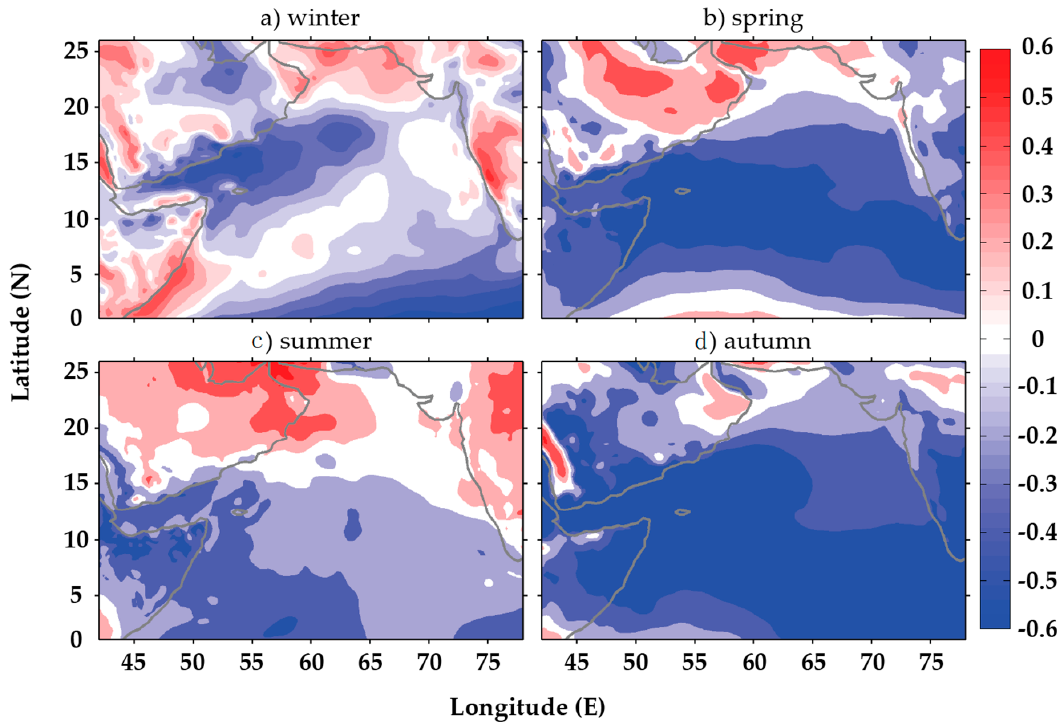
Figure 9. The spatial correlation between zonal wind in the Arabian Sea and Multivariate ENSO Index (MEI) for the period from 1993–2018 (the sea level anomaly (SLA) data